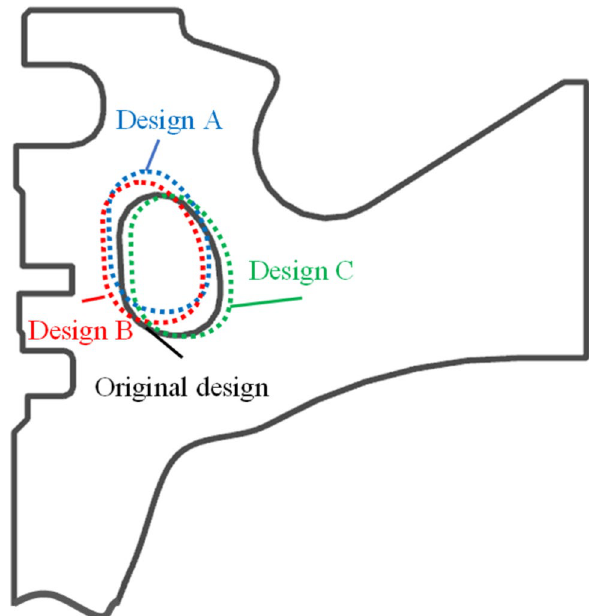
Figure 10. The three optimal gallery sections.